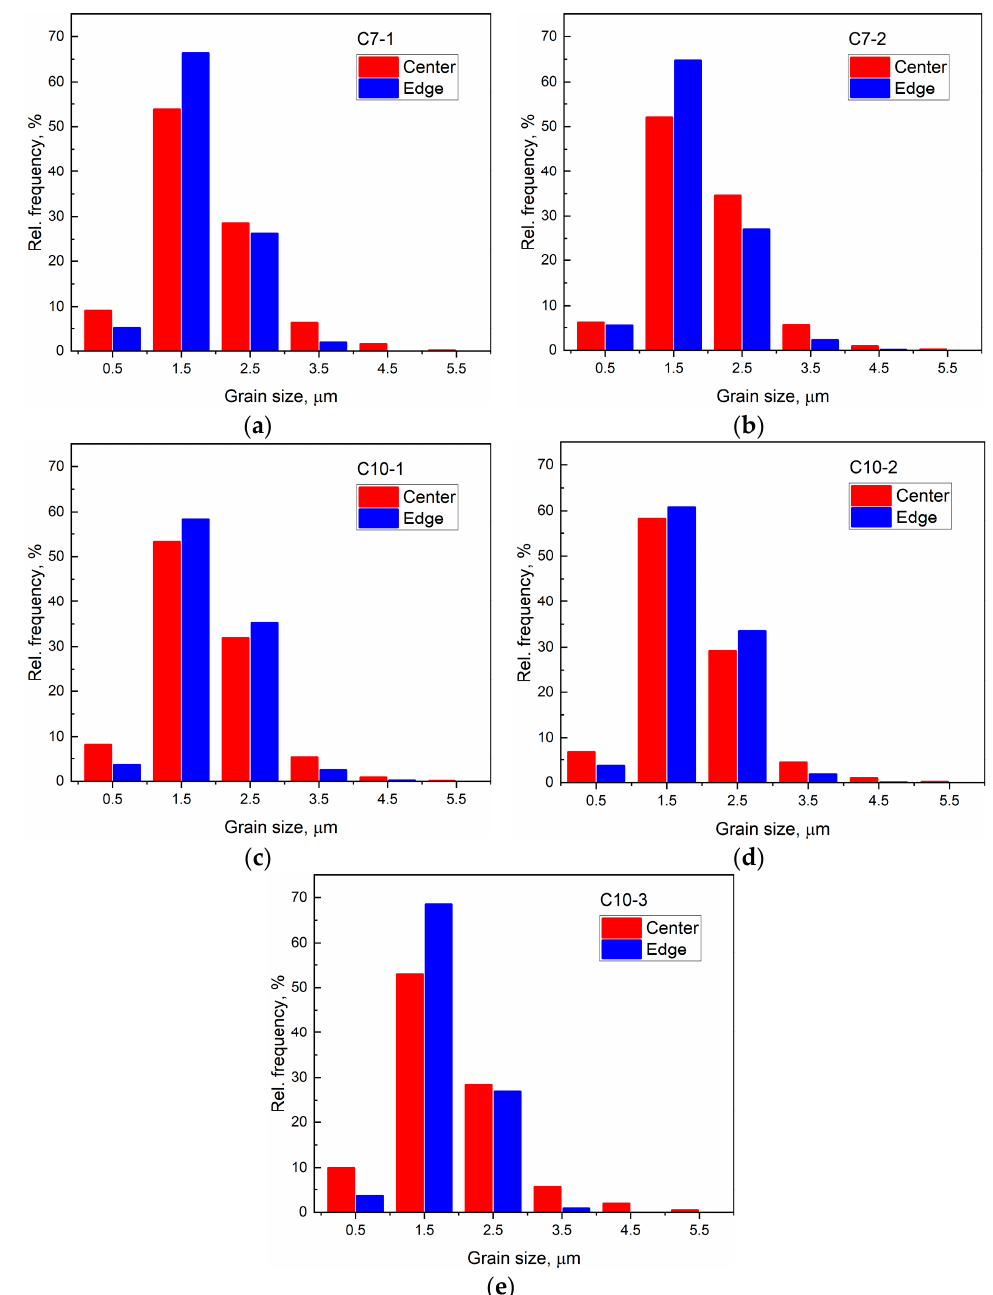
Figure 8. Grain-size distribution histograms in the central and edge areas of samples: ( a ) C7-1 (near the C7 wire fracture region), ( b ) C7-2 (far from the fracture region), ( c ) C10-1 (from the region of the C10 wire near the 1st clamp), ( d ) C10-2 (from the center of the C10 wire), and ( e ) C10-3 (from the region of the C10 wire near the 2nd clamp). For better visualization, the histograms are shifted along the abscissa axis by the width of the base of the histogram columns to the left and right relative to the true position.